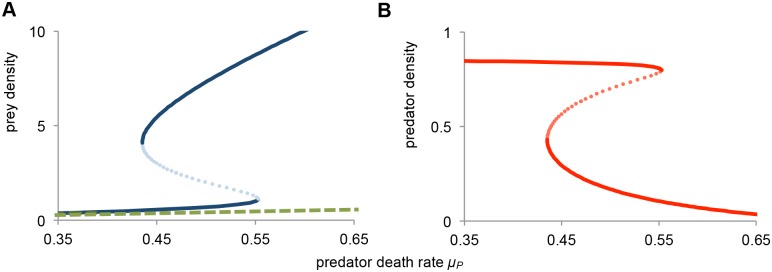
Bistability in the absence of disease.Bifurcation diagram as a function of predator death rate μ
P. (a) Equilibrium prey density, juveniles J
S in solid line (blue), and adults A in dashed line (green), and (b) Equilibrium predator density P (red). The equilibrium curves exhibit a so-called catastrophe fold, with a bistable region for 0.435 < μ
P < 0.553. The unstable (saddle node) state is indicated with the dotted lines. Model parameters are b = 1, c = 1, d = 1, n = 1, φ = 1, μJ = 0.05, μ
A = 0.1, and μ
P variable.